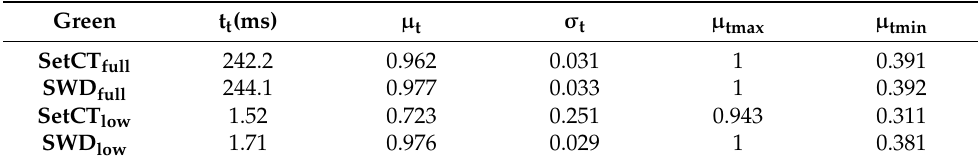
Table 4. Performance evaluation of the THz-FDS classification of a green sample. Table 5. Performance evaluation of the THz-FDS classification of a white sample.